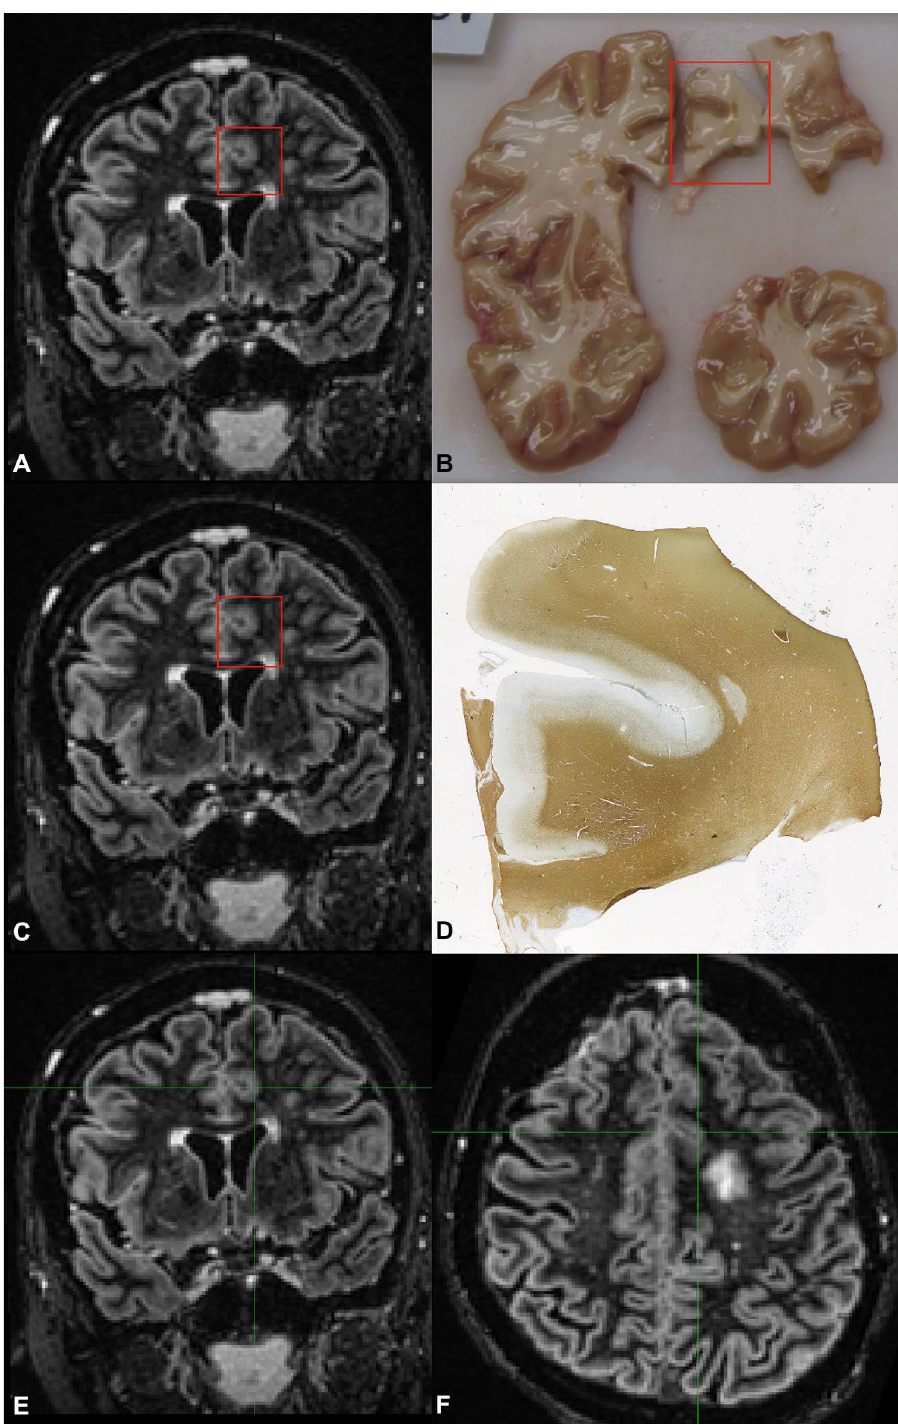
Figure 3. Overview of the histopathological tissue sample to MRI matching procedure. ( A ) The coronal double inversion recovery (DIR) MRI is matched to ( B ) a photograph of the tissue sample. Then, the coronal DIR MRI ( C ) is matched to the histopathological sample ( D ) coming from the tissue sample. Next, the cross-hair is used to translate the histopathological tissue sample location from the coronal DIR ( E ) to the axial DIR ( F ); (generated using Adobe Illustrator—Adobe Inc., 2019. Adobe Illustrator, Available at https:// adobe. com/ produ cts/ illus